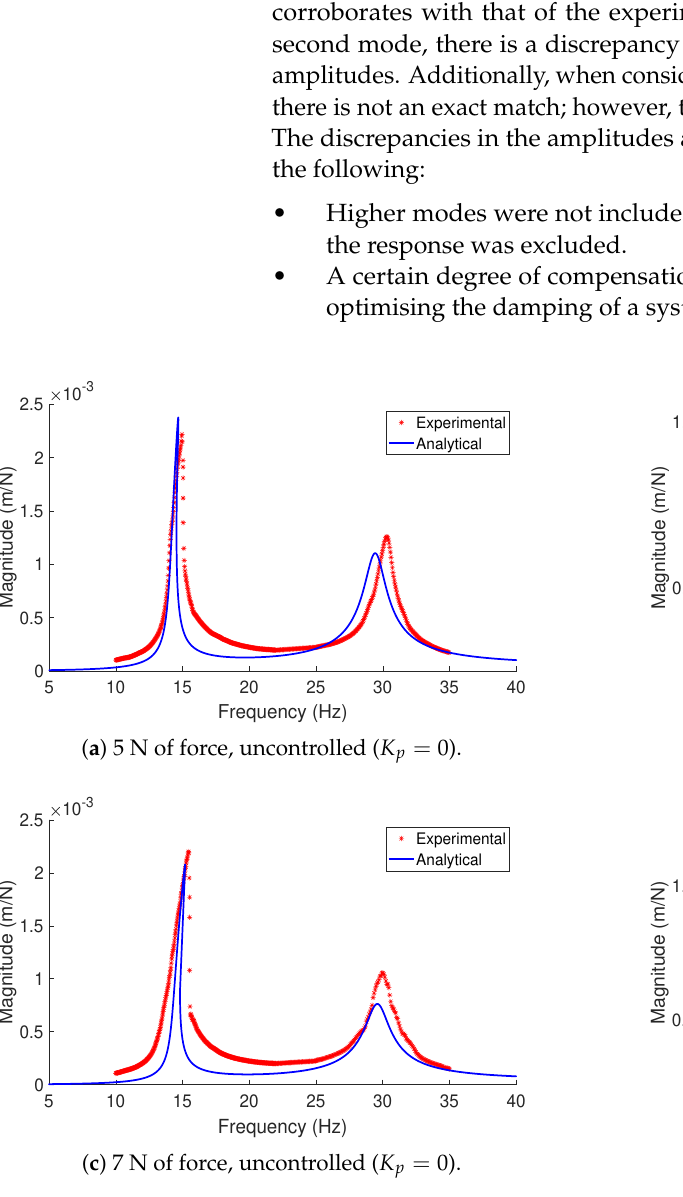
Figure 9. A comparison between the experimental data obtained across the first and second resonance frequencies, and the data simulated by the analytical model at ( a ) a force level of 5 N with no control applied, ( b ) a force level of 5 N with control applied, ( c ) a force level of 7 N with no control applied, and ( d ) a force level of 7 N with control